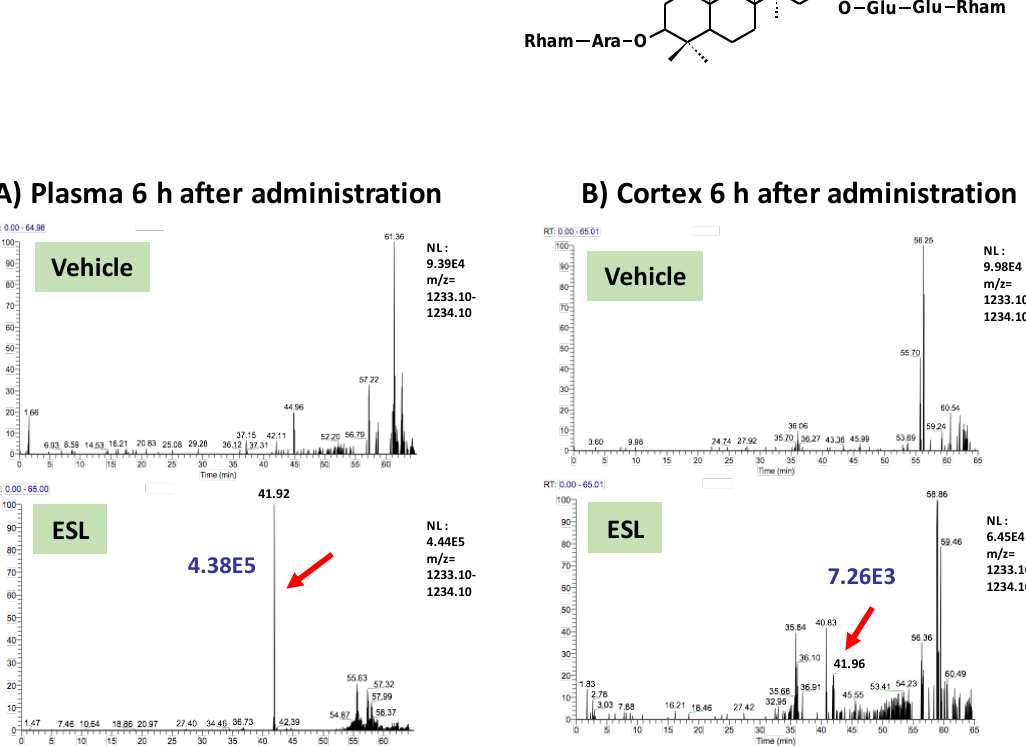
Figure 4. Ciwujianoside B was detected in plasma and the cerebral cortex after oral administration of the leaf extract of E. senticosus. A structure of ciwujianoside B and LC-MS charts of plasma ( A ) and cerebral cortex ( B ) from vehicle-treated and leaf extract-treated mice 6 h administration of the extract. Red arrows indicate a peak of ciwujianoside B. A blue value means intensities of the peak.